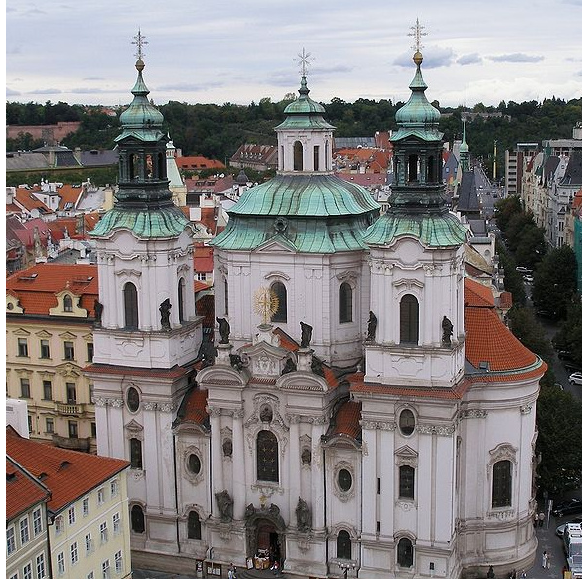
Figure 2. Image of St. Nicholas church main